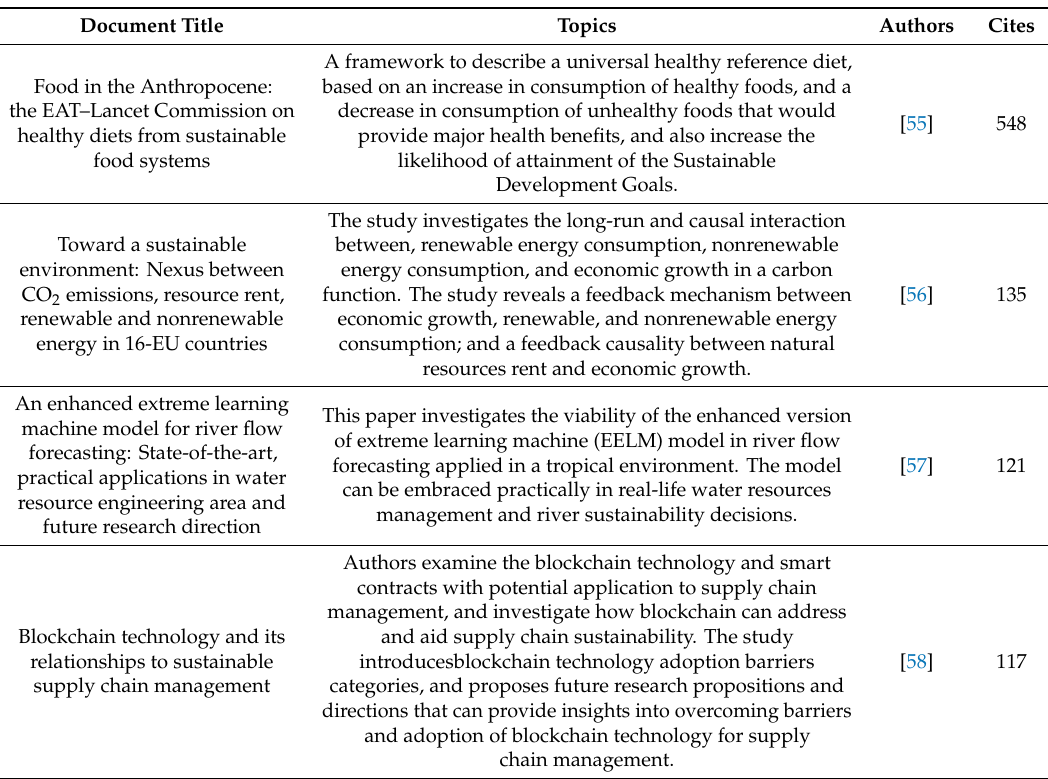
Table 10. Most cited documents in 2019–2020.